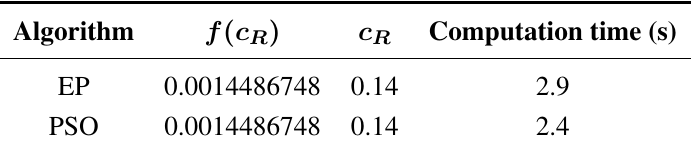
Table 2. Results in Problem 2 (the stop-loss reinsurance model) using the EP and PSO